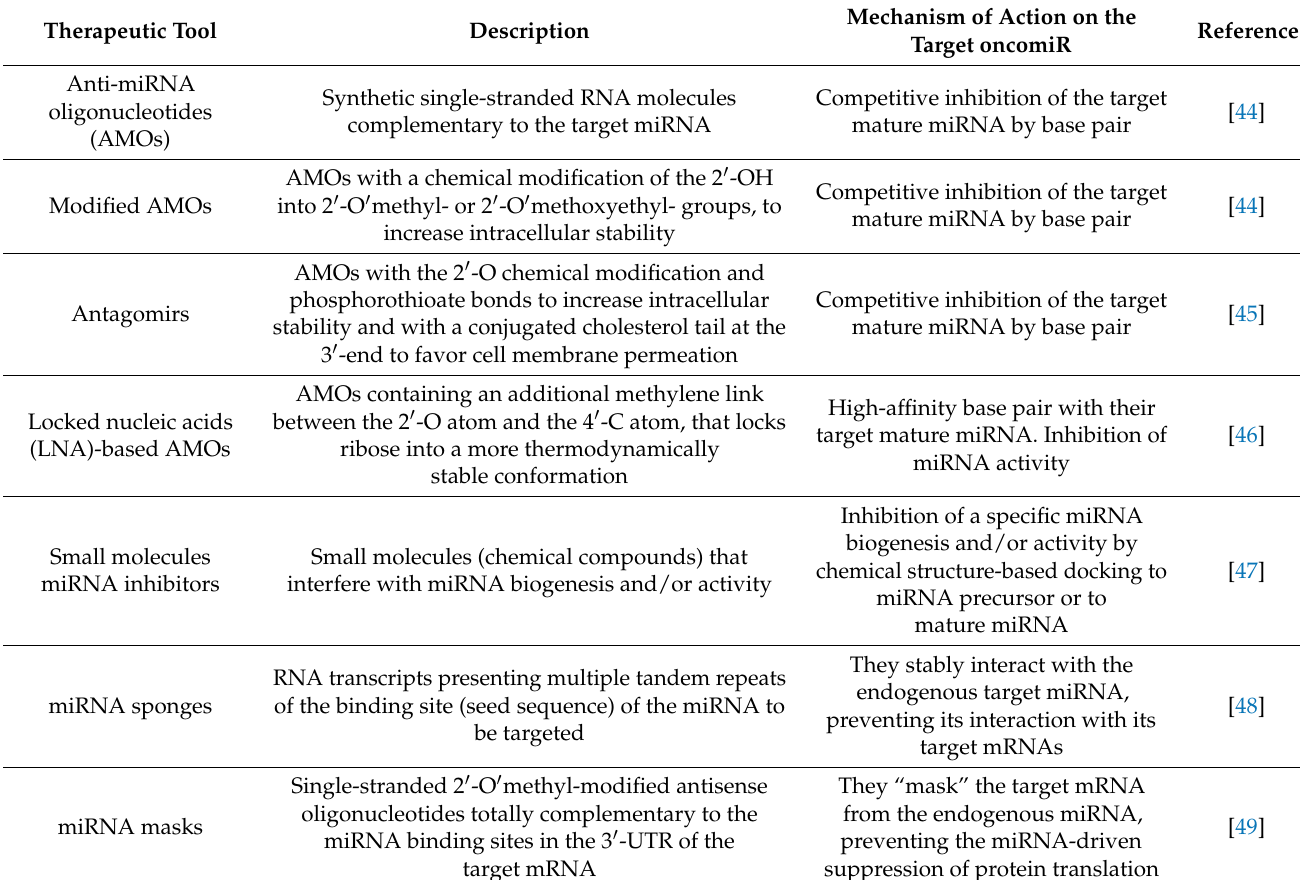
Table 2. miRNA inhibition target therapies for